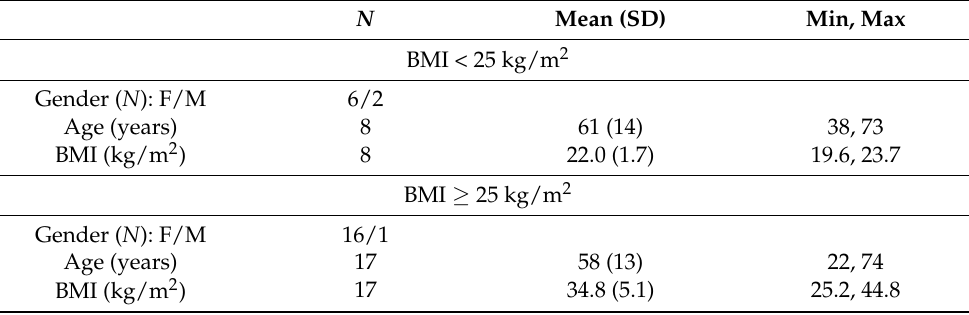
Table 1. Characteristics of French participants.